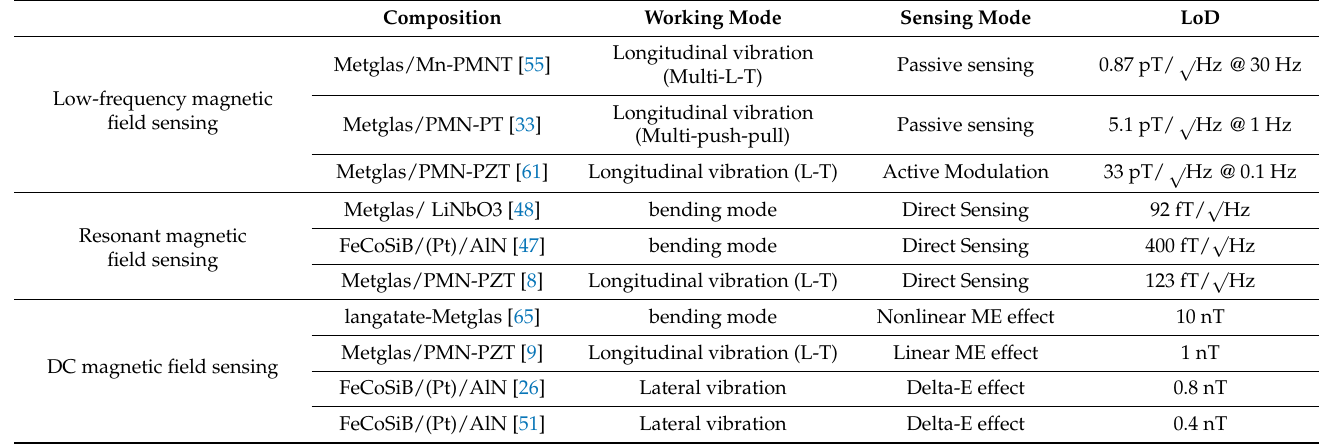
Table 2. Performance summary of typical magnetoelectric sensors.